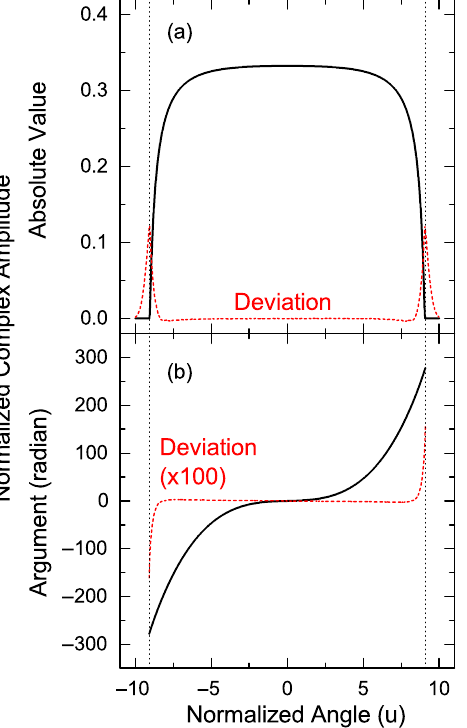
ˆ E FIG. 4. Complex amplitude 0 as a function of the horizontal angle u in terms of (a) absolute value and (b) argument. The black solid line shows the semianalytical results using Eq. (29), while the red dashed lines show deviations from the more accurate numerical results using Eq.